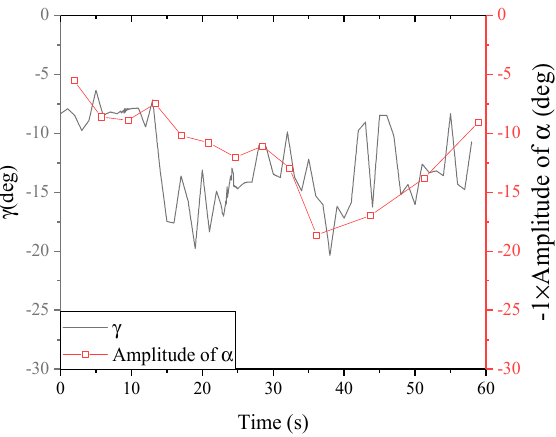
Figure 23. Comparison of yaw angle and variation amplitude of angle of attack measured by probe in